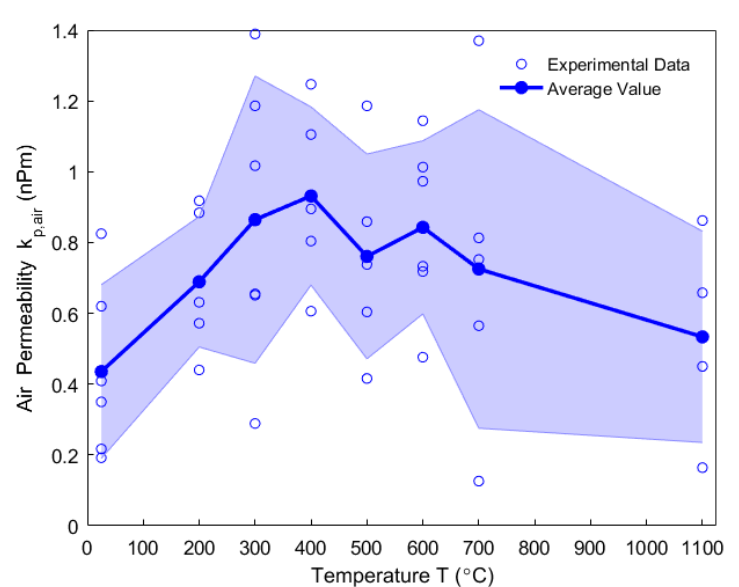
Figure 7. Air permeability of baked-up anodes to different high temperatures. At room temperature, the air permeability of the green anode is 0.436 nPm. As